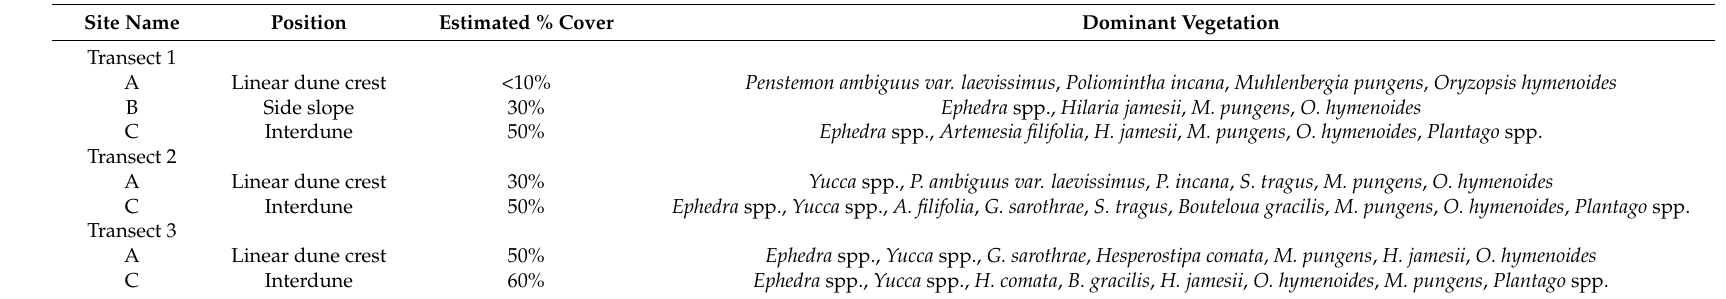
Table 2. Dominant vegetation and vegetative cover for Gold Springs coring